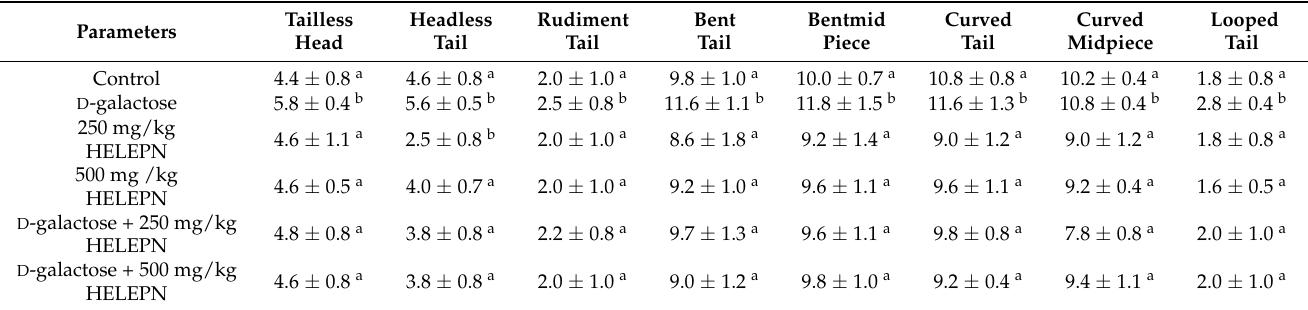
Table 3. Effect of graded doses of HELEPN on sperm morphology.